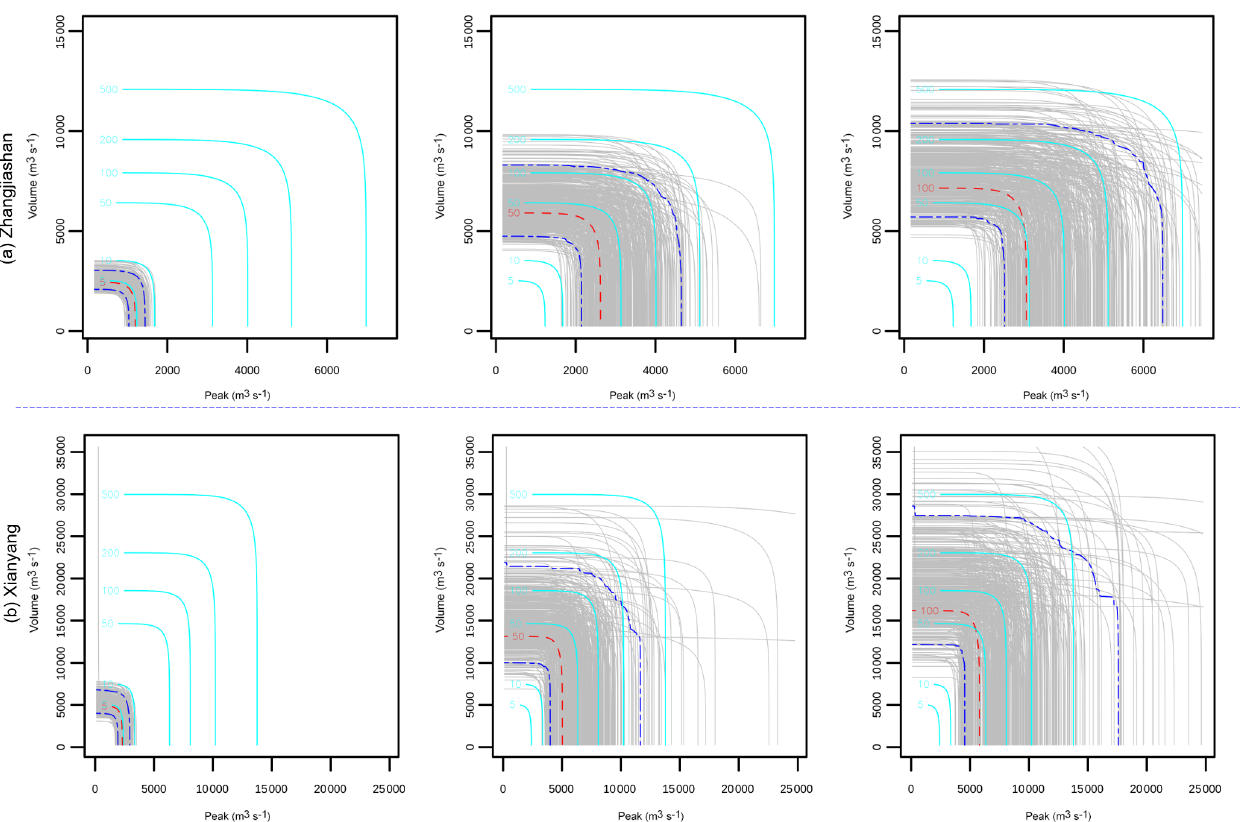
Figure 4. Uncertainty quantification of the joint RP in “AND”: the red dash lines indicate the predictive means, the two blue dash lines, respectively, indicate the 5% and 95% quantiles, and the grey lines indicate the predictions under different parameter samples with the same joint RP of the red and blue dash lines. The cyan lines denote the predictions under different return periods, with the model parameters being their mean values.